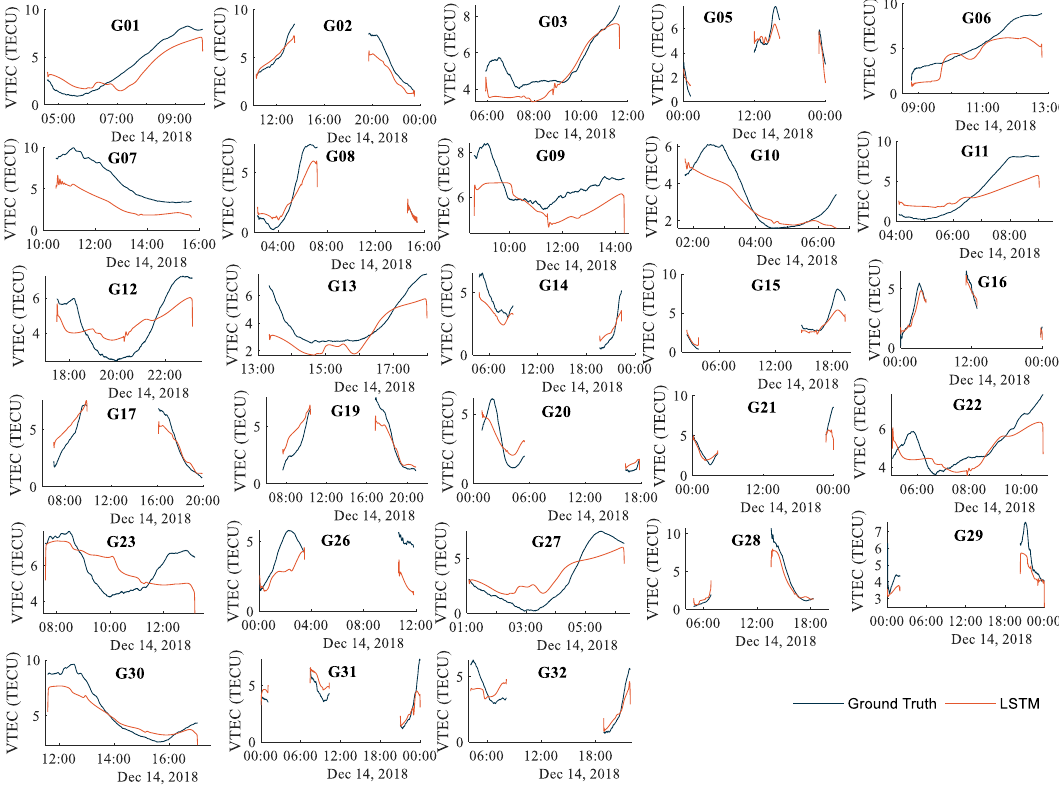
Figure 7. Vertical TEC of each GPS satellite between the GPS ground truth values and our LSTM method’s results on 14 December 2018, for ’bor1’